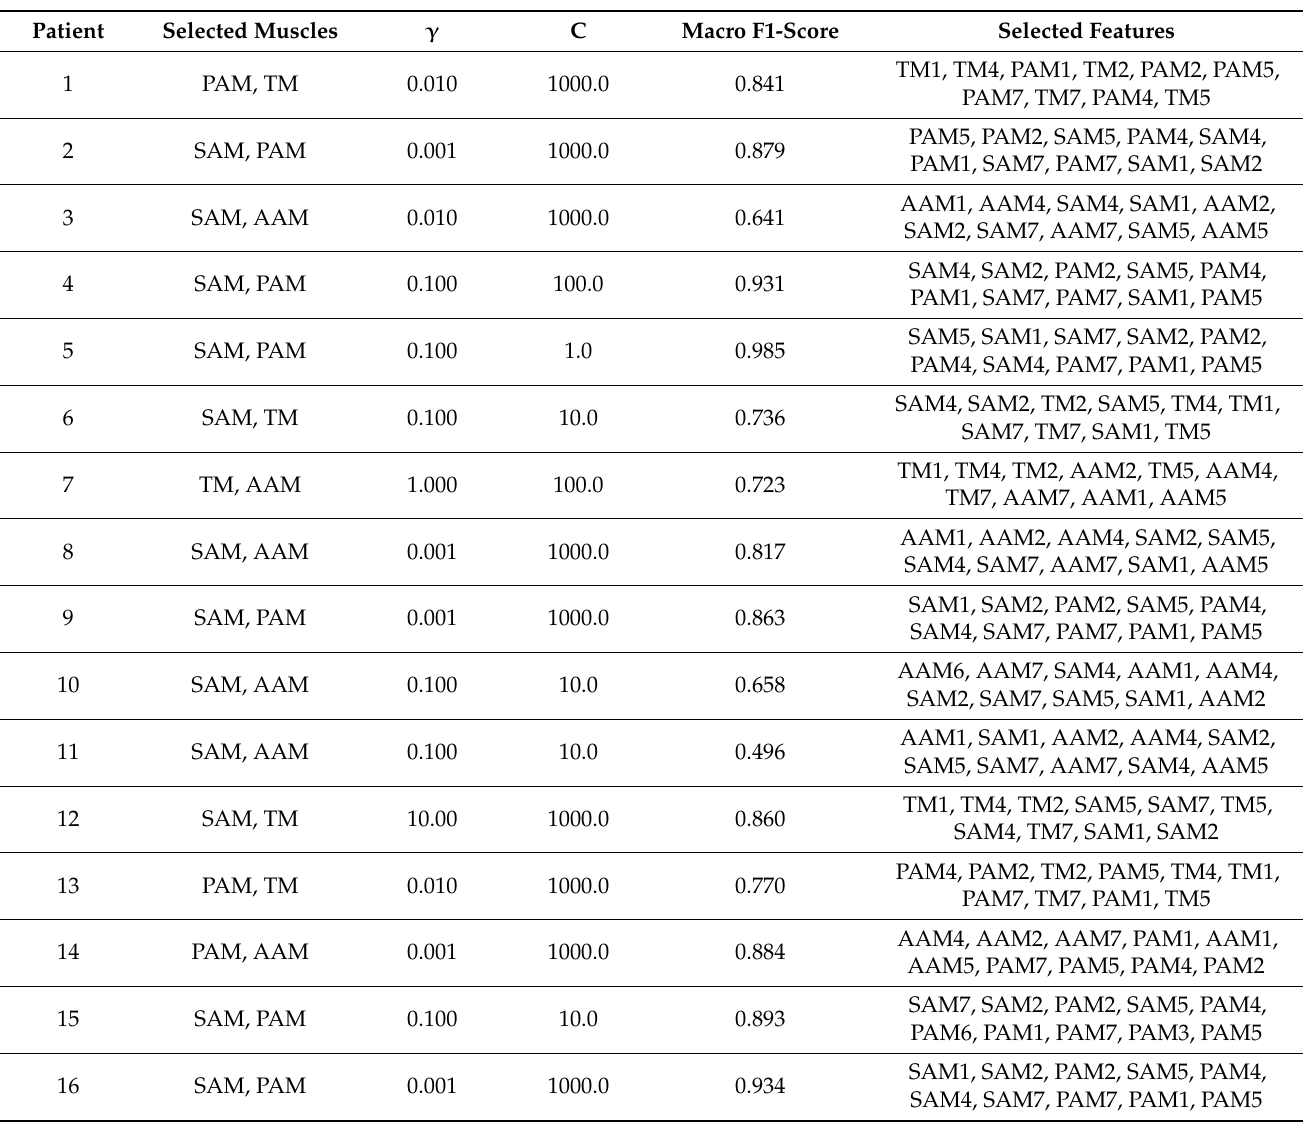
Table 2. Model parametrization with the best performance (wl = 66 ms, two muscles). Selected features are reported with reference to Supplementary Table S1. Order given is according to mutual information